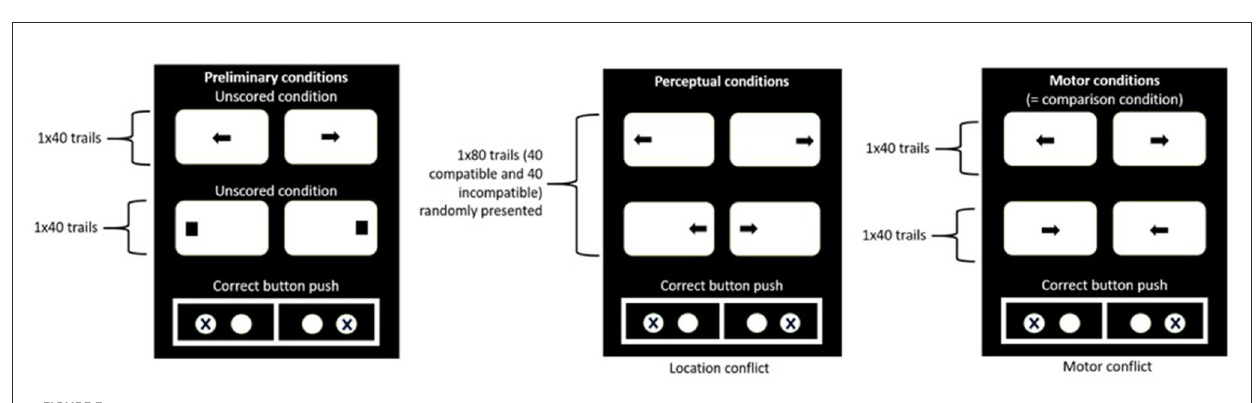
FIGURE3 Panels of stimuli presented in the different conditions of the